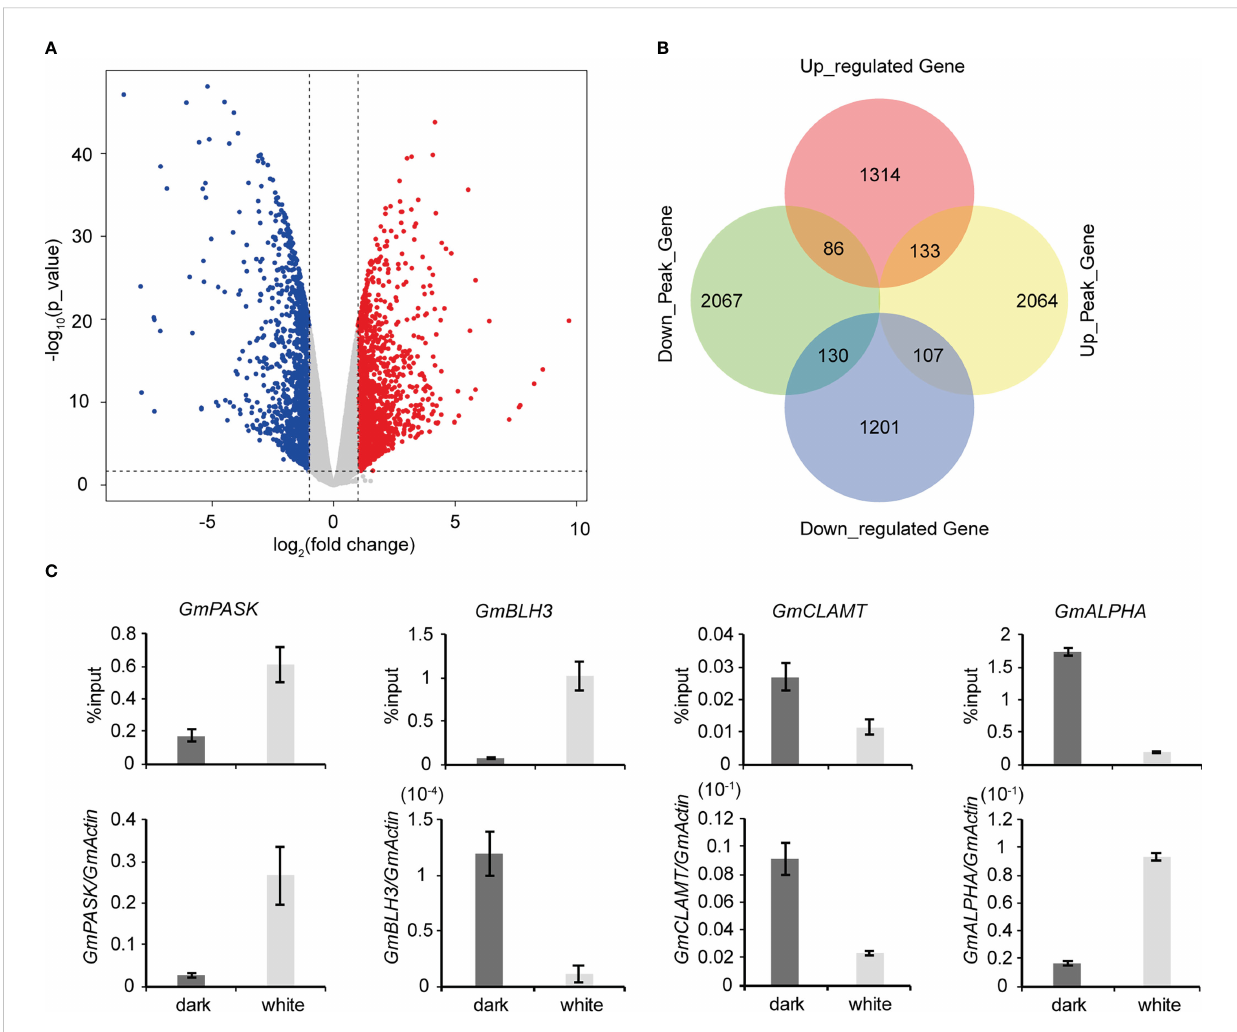
FIGURE 4 Conjoint analysis of MeRIP-seq and RNA-seq data. (A) Scatter plots showing the differential expression of genes under dark and continuous white light conditions. |logFC|>1, FC= RPKM (dark)/RPKM (white), p value<0.05. (B) Venn diagram showing the distribution of genes with signi fi cant changes in both the m 6 A peaks and mRNA levels. (C) Validation of differential m 6 A modi fi cation and differential gene expression. The values represent the means ± SD